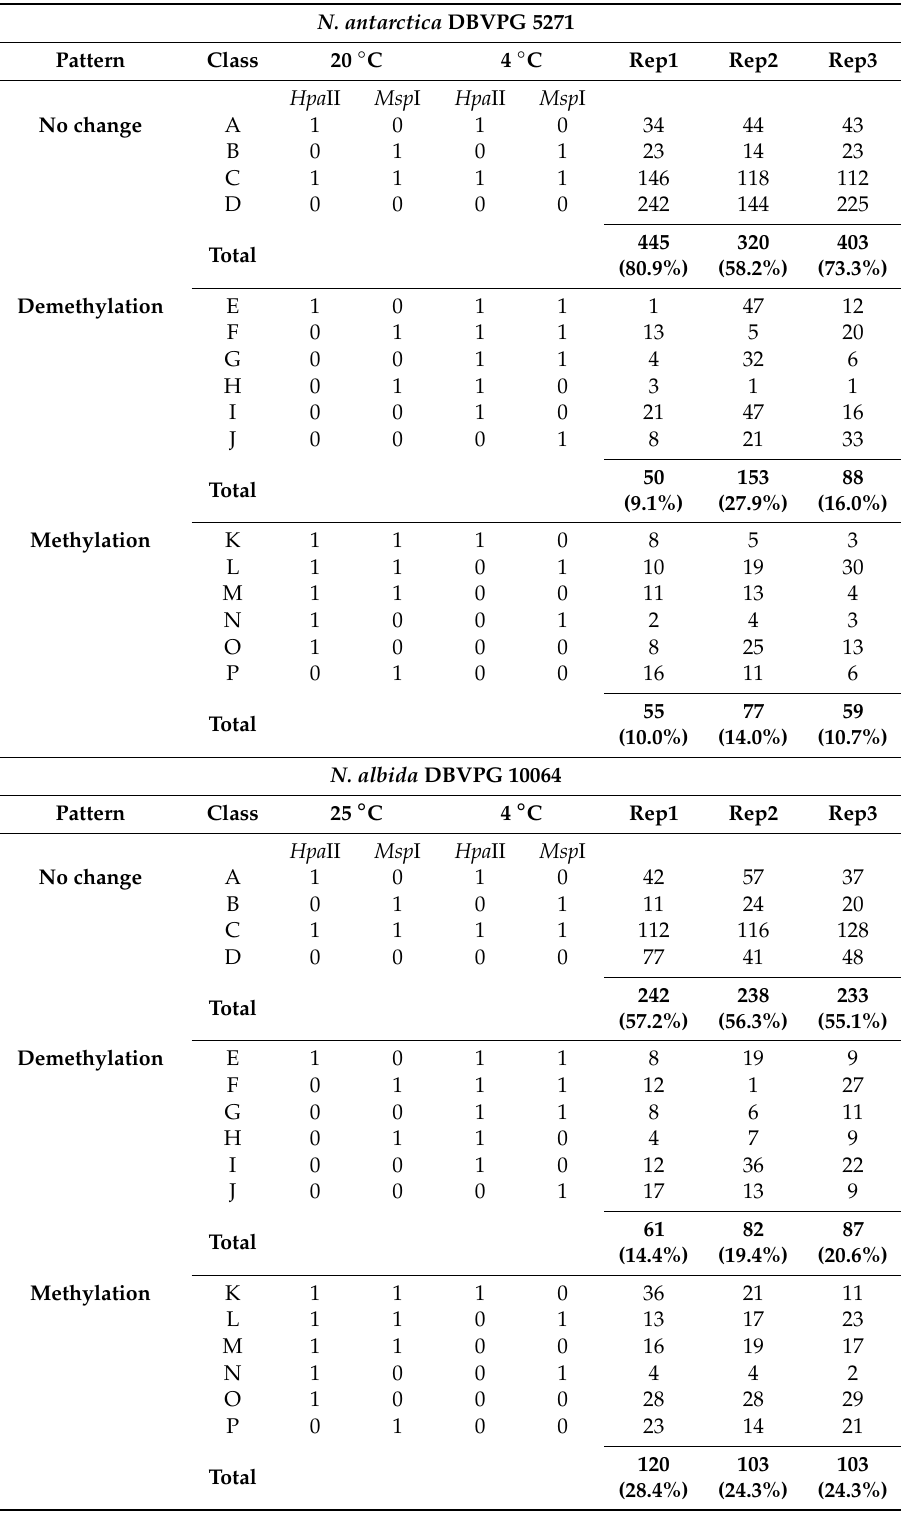
Table 2. Analysis of DNA methylation patterns in N. antarctica DBVPG 5271 and N. albida DBVPG 10064 under cold conditions compared with control